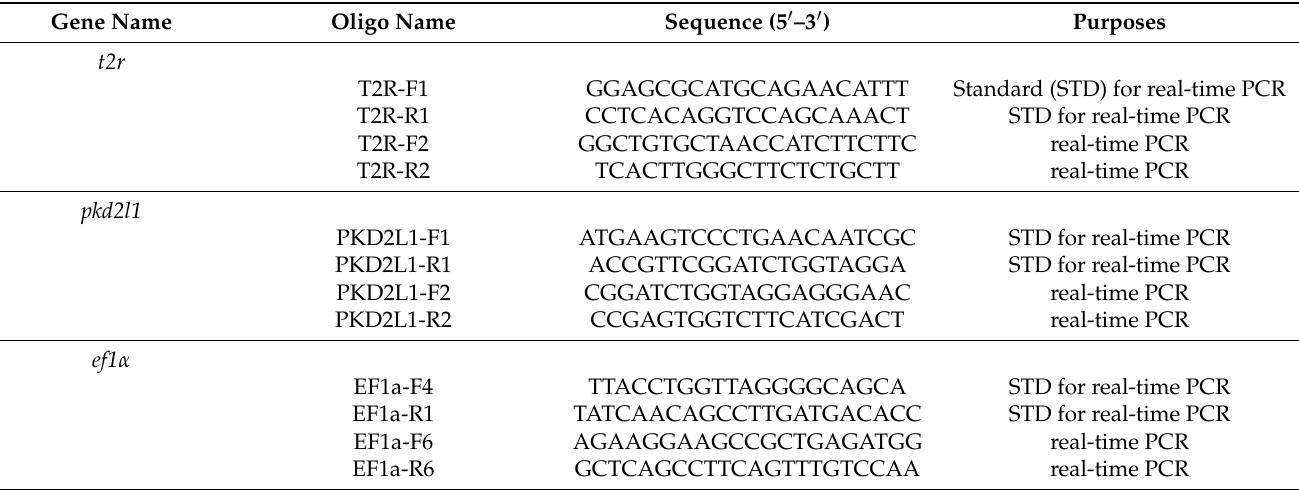
Table 3. Primers used for real-time qPCR